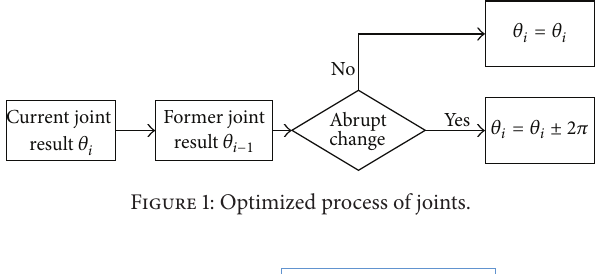
Figure 1: Optimized process of joints.